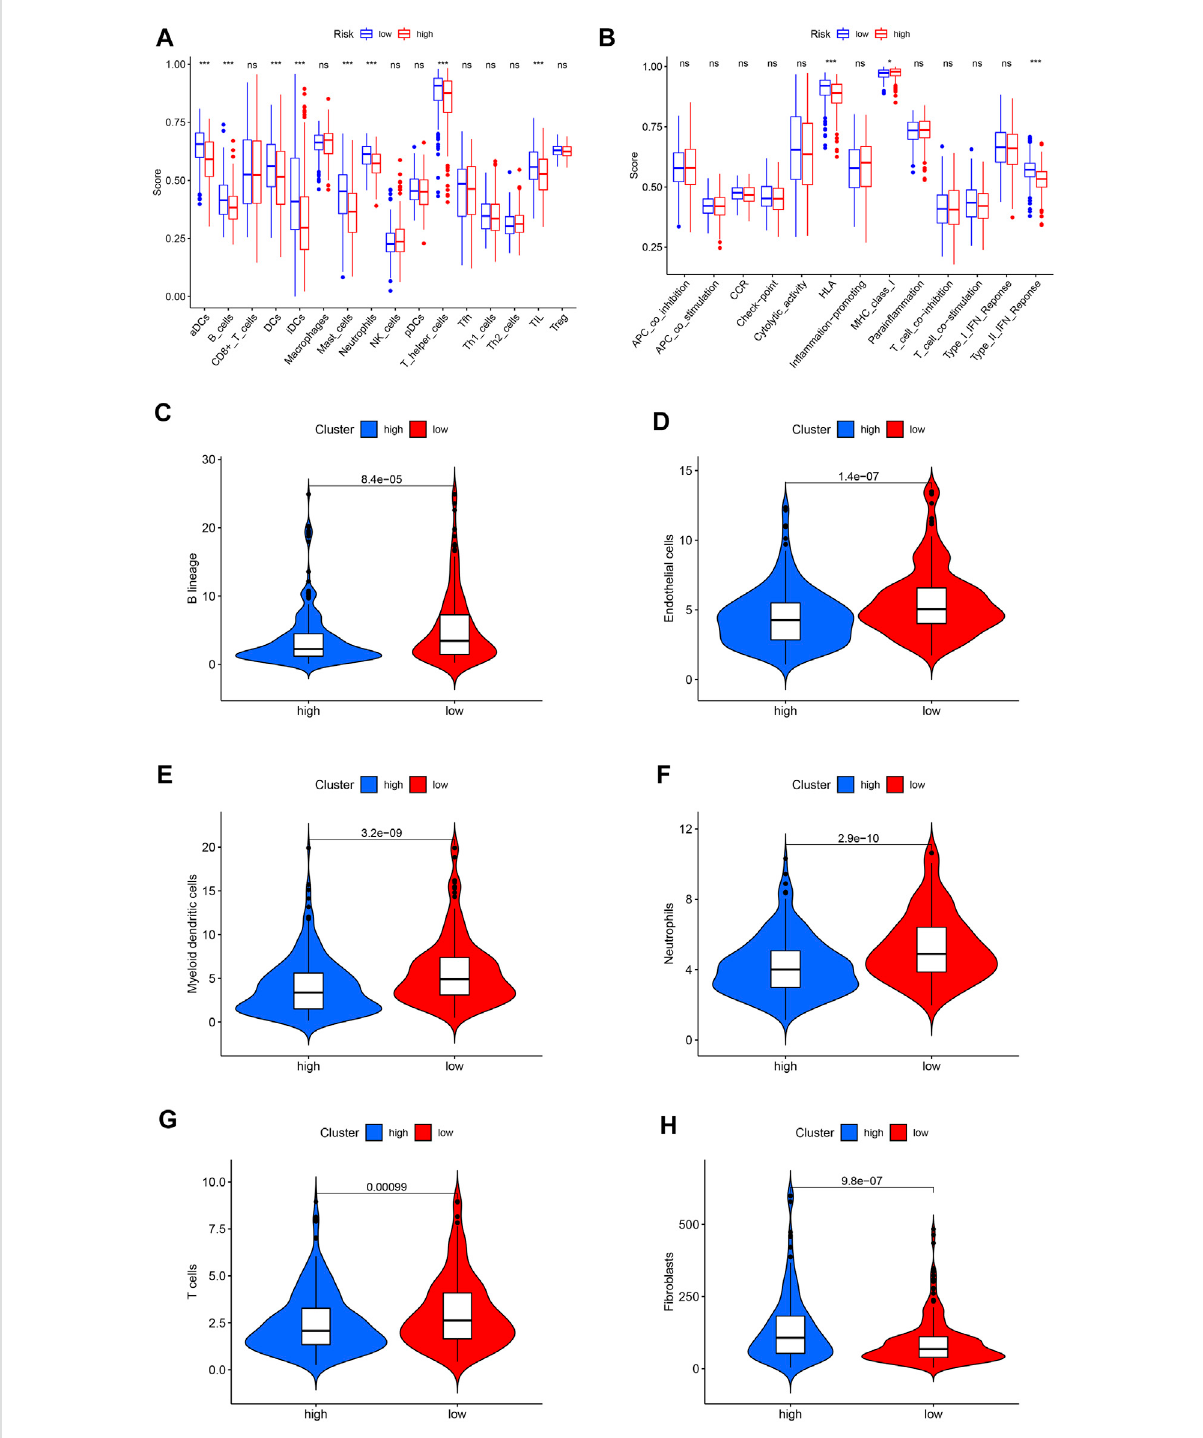
FIGURE 6 The landscape of immune in fi ltration in LUAD. (A) Differences of immune cells in the high- and low-risk groups. (B) Differences in the immune functionbetweenhigh-andlow-riskgroups. (C) ViolinplotofBlineage. (D) Violinplotofendothelialcells. (E) Violinplotofmyeloiddendriticcells. (F) Violin plot of neutrophils. (G) Violin plot of T cells. (H) Violin plot of fi broblasts. The horizontal line in the Violin plot represents the median, and blue and red represent the high-risk and low-risk groups, respectively. p < 0.05 shows the signi fi cant statistical difference between two